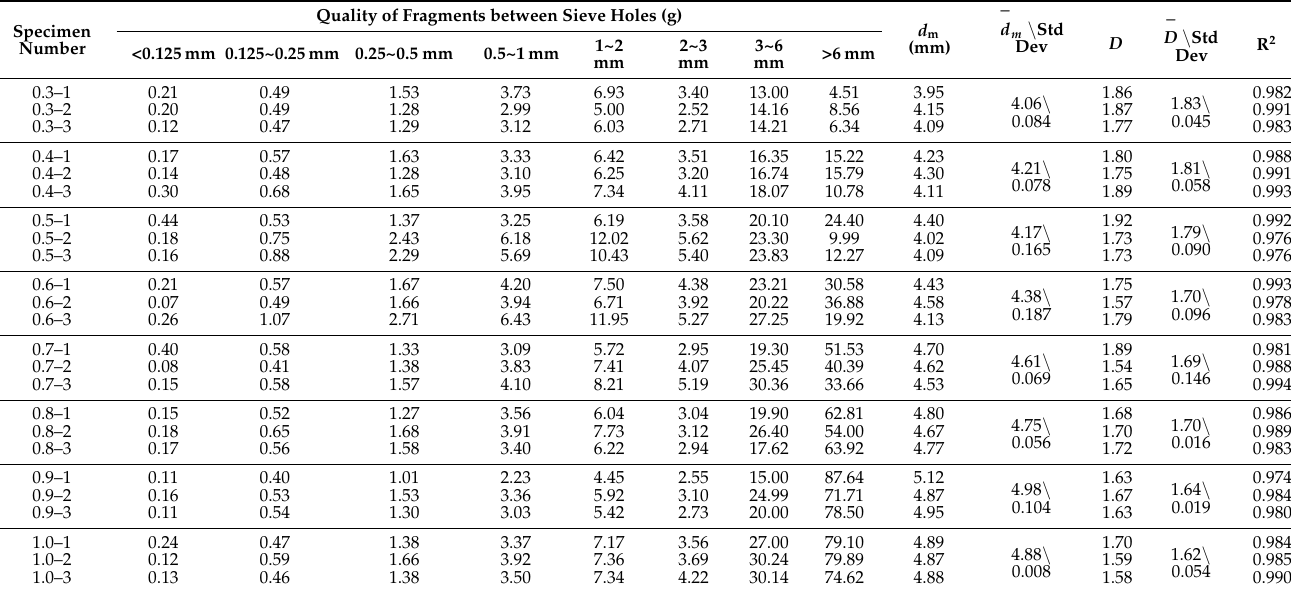
Table 2. Characteristic table of particle size distribution and fractal dimension of specimens with different l / d .